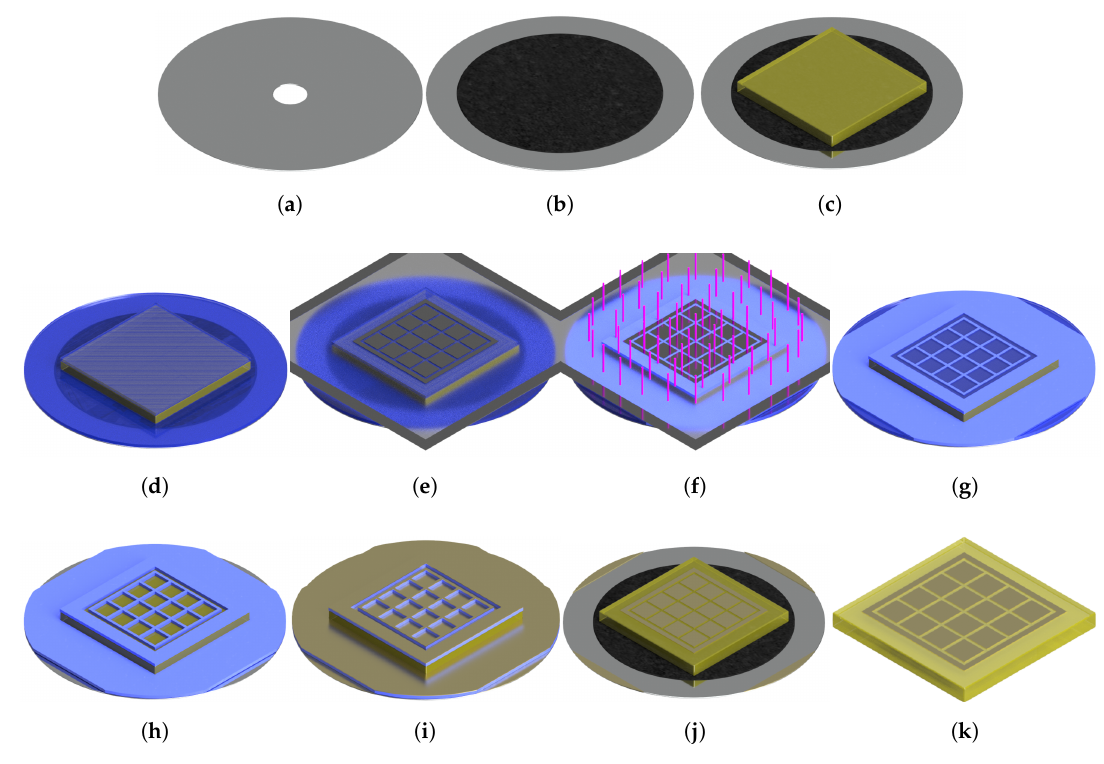
Figure 2. Photolithography process using negative resist for pixelated LISe semiconductor sensor fabrication (16-channel pixel detector with square pixels and guard ring [16] shown for